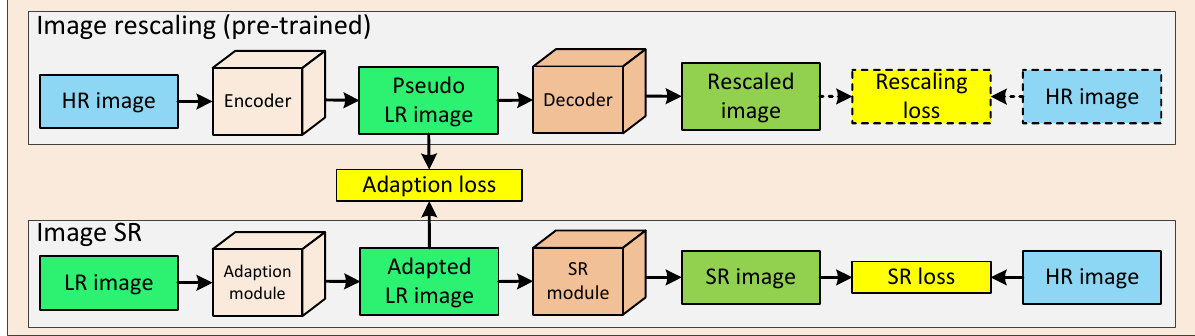
Figure 1. An overview of our proposed RSAR